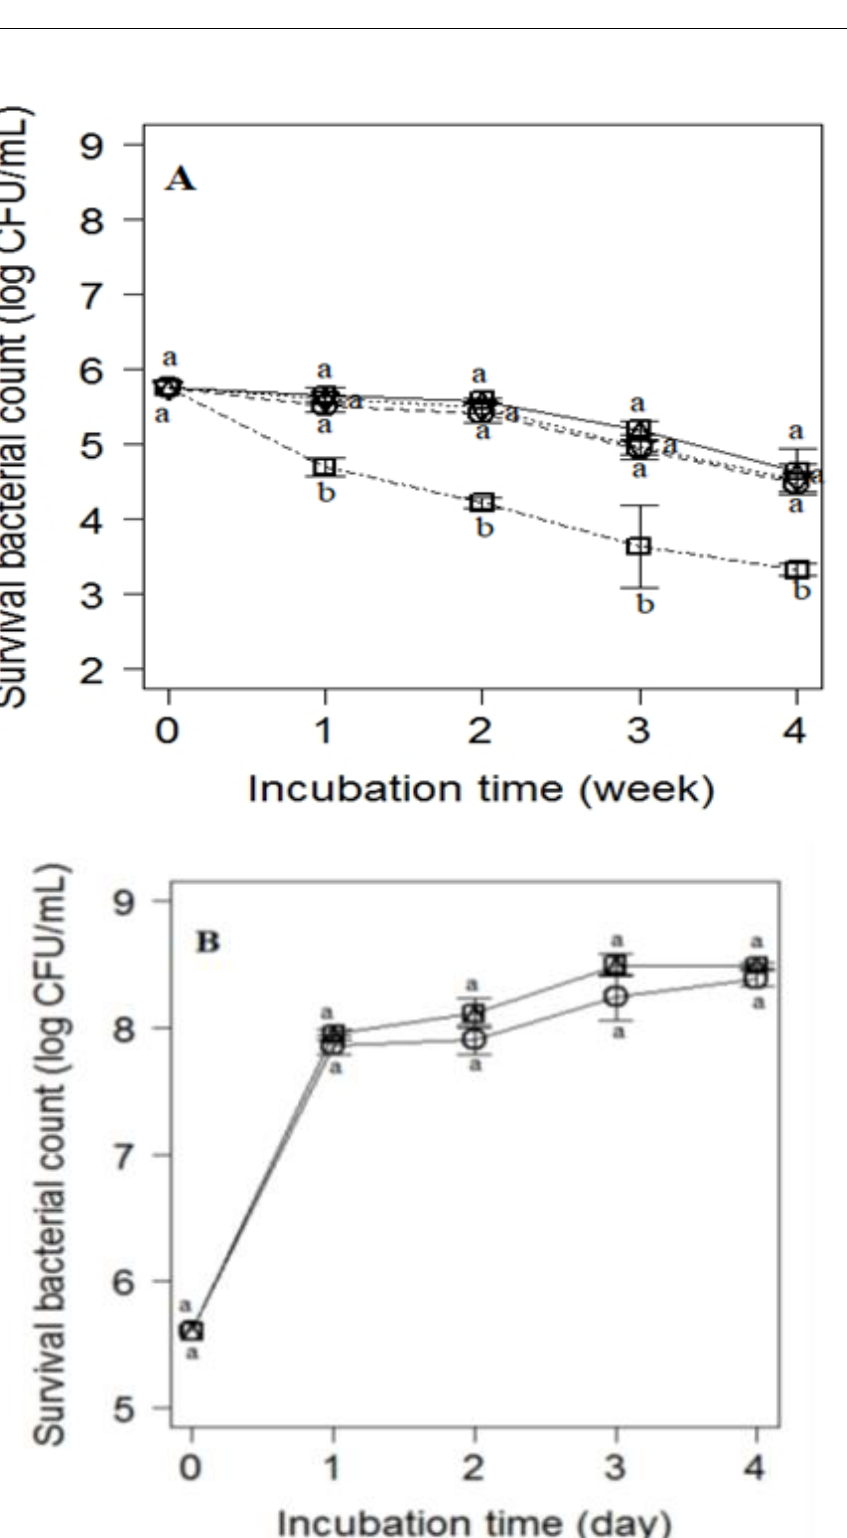
Figure 2. Inhibitory effect of D-tryptophan on the viable counts of E. coli O 26 inoculated into PYG media ( A ) at 4 ◦ C at various concentrations of D-Trp. 0 mM (solid line), 20 mM (dotted line), 30 mM (dashed line), and 40 mM (dot-dashed line), ( B ) at room temperature (25 ◦ C) at 40 mM D-Trp (0 mM D-Trp, □ ; 40 mM D- Trp, Ο). Values are the mean ± standard deviation of three independent trials. Values with different letters are significantly different ( p < 0.05).